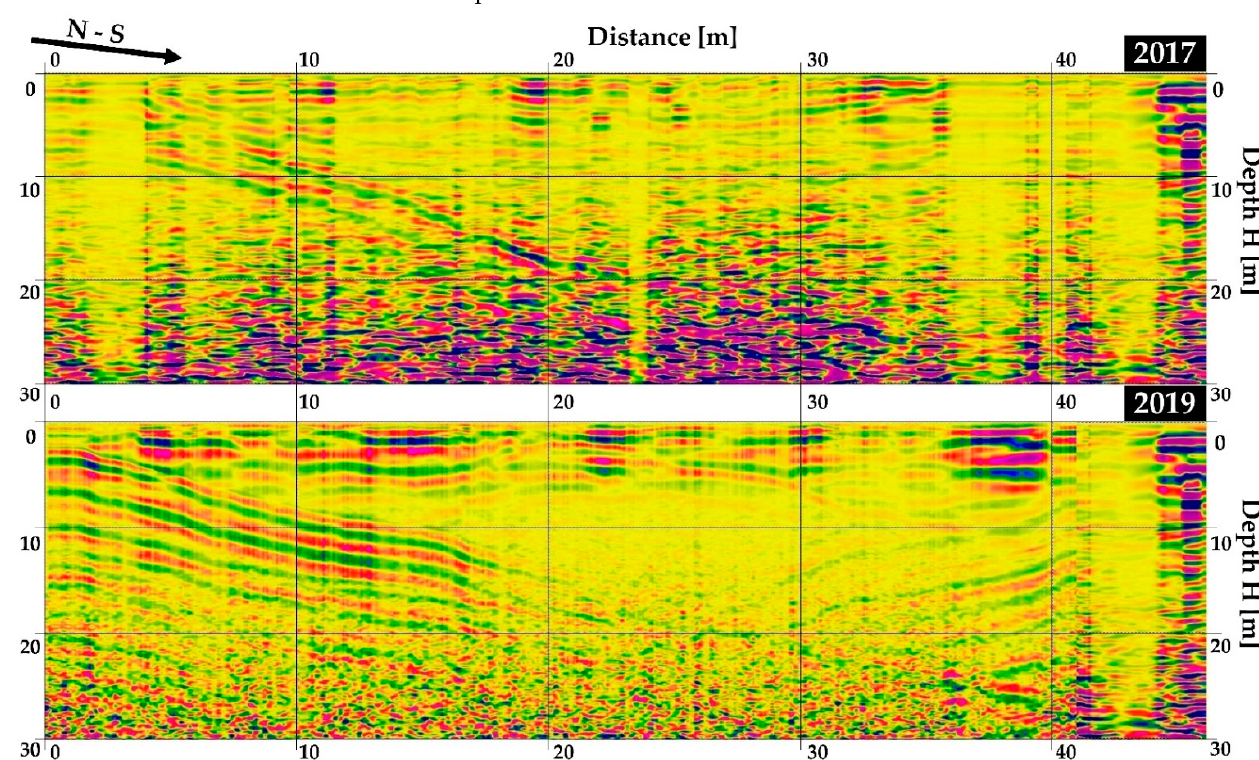
Figure 13. GPR longitudinal profile from 2017 and 2019.